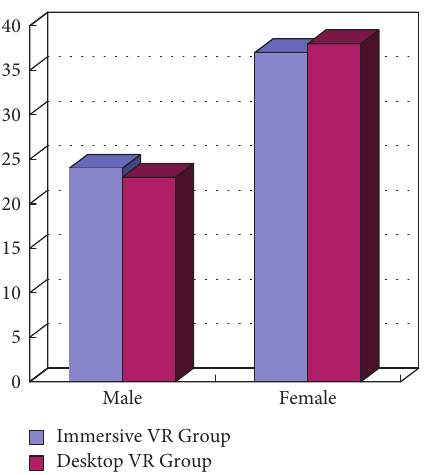
Figure 3: Experimental grouping